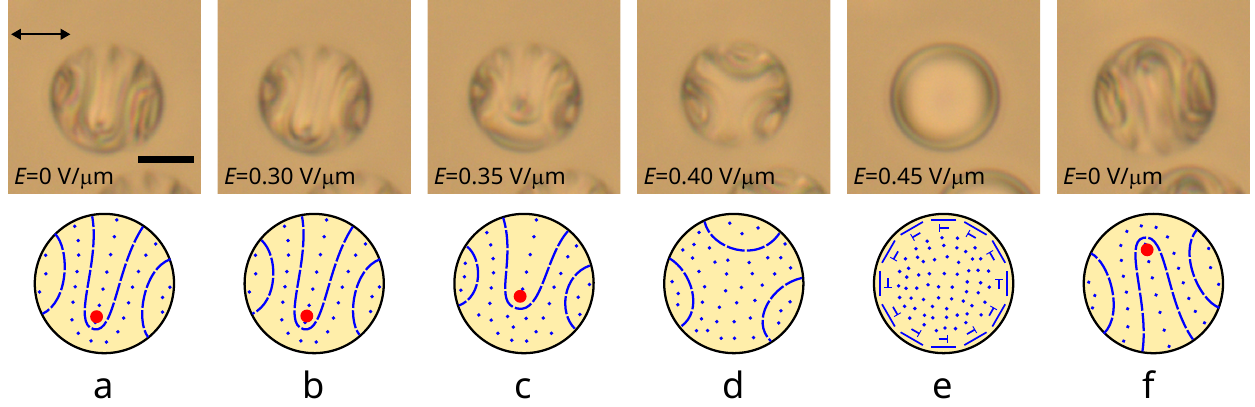
Figure 6. POM images of CLC droplet at N 0 = 7.7 taken with one polarizer ( top row ) and correspond- ing schemes of cholesteric layers ( bottom row ). CLC droplet before ( a ), under an electric field E rise equal to 0.30 V/ µ m ( b ), 0.35 V/ µ m ( c ), 0.40 V/ µ m ( d ), 0.45 V/ µ m ( e ) and after decreasing the electric field to E reduc . = 0 V/ µ m ( f ). The red circles indicate the cross-section of the λ + 1/2